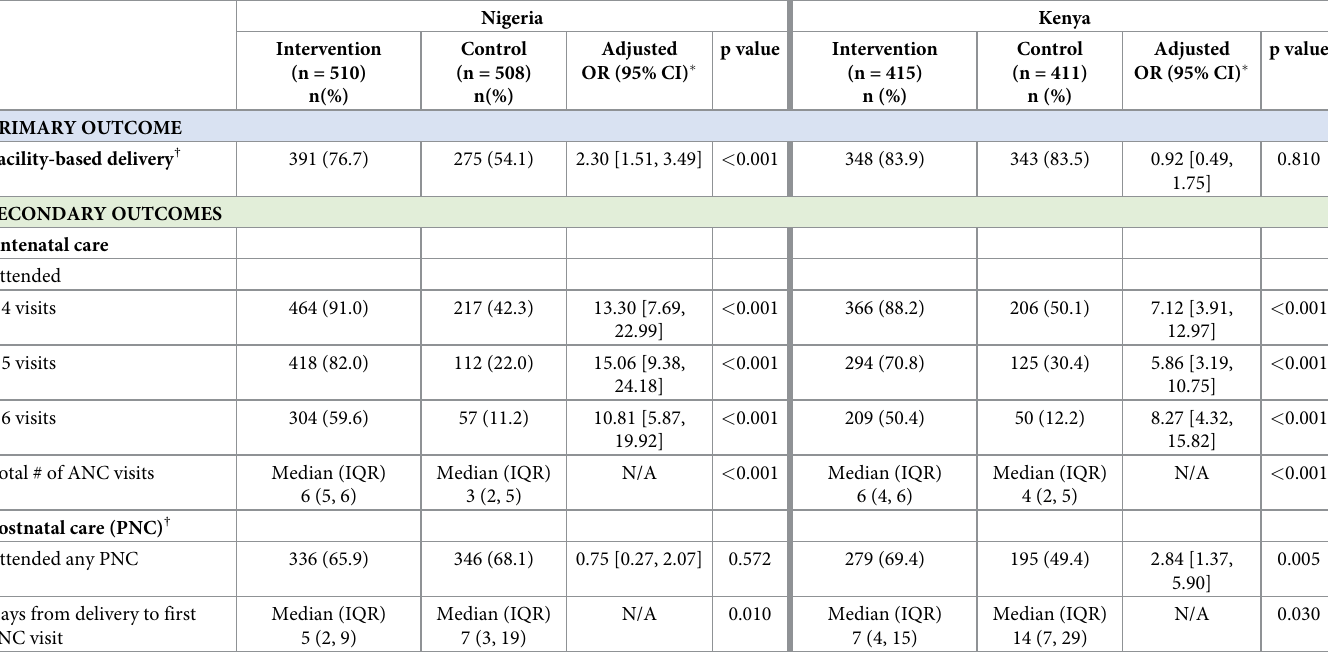
Table 2. Effect of G-ANC intervention on service utilization: Facility-based delivery, ANC and